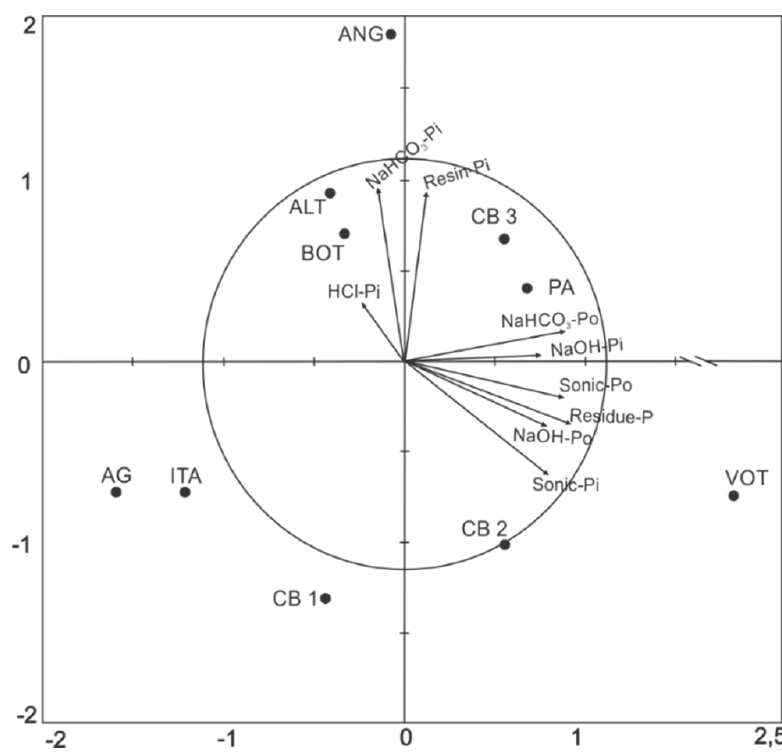
Figure 1. Ordination diagram produced by principal component analysis of soil P fractions (0–20 cm) in